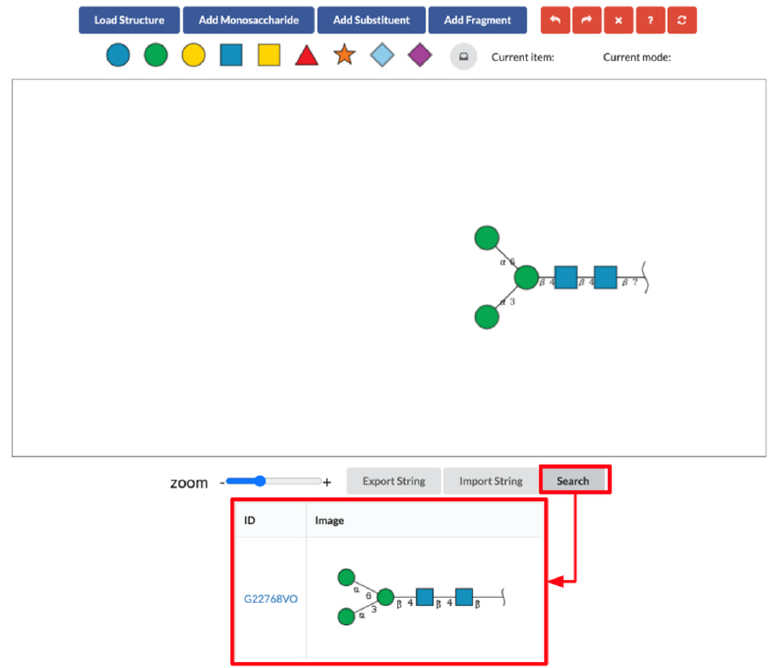
Figure 7. Image of glycan search. The result of the search includes GlyTouCan ID and the glycan